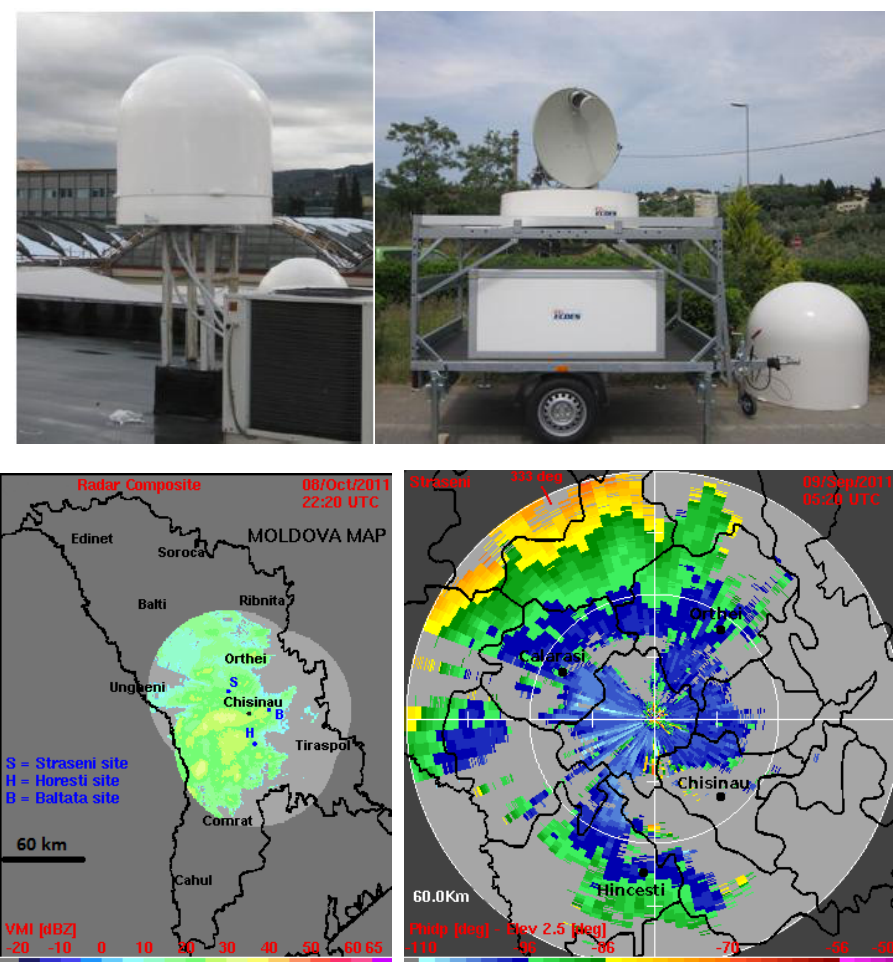
Figure 3. Pictures of fixed (top left panel) and mobile (top right panel) mini-radars, a sample reflectivity map composite from the three mini-radar sites (bottom left panel) and a differential propagation phase shift map (bottom right panel), taken from the Straseni radar site at 60 km range on Sept. 9, 2011.